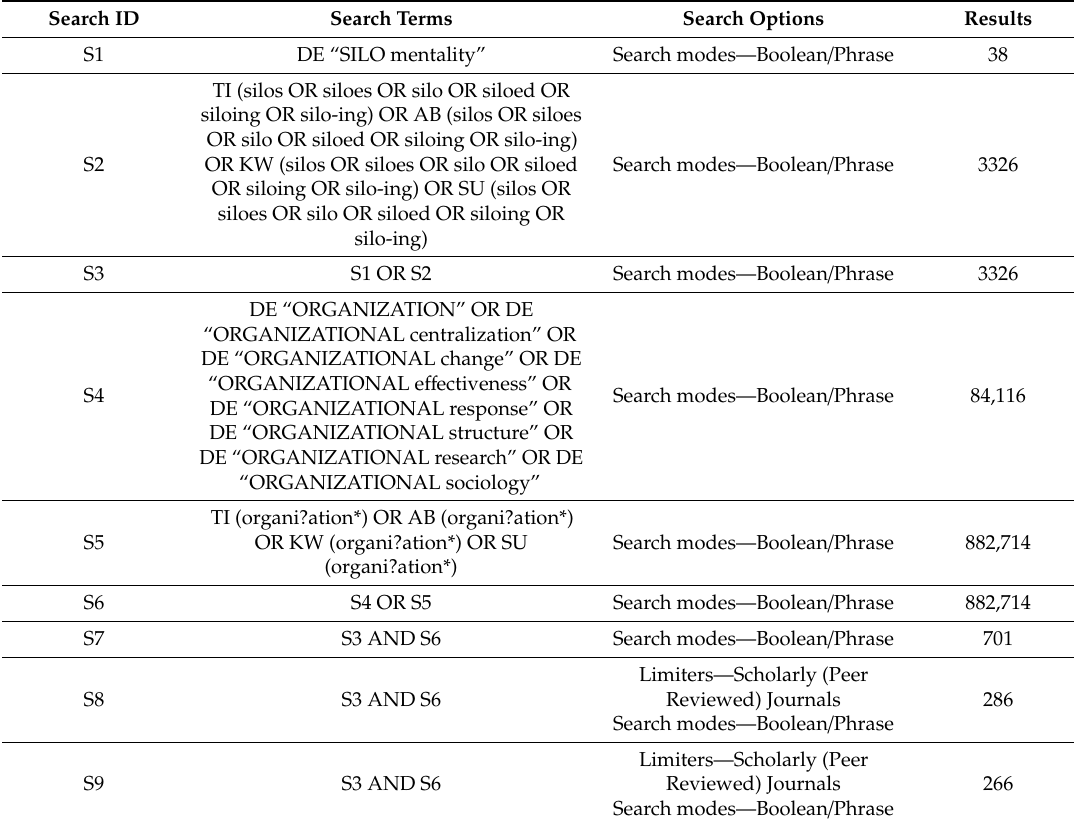
Complete search strategy on Business Source Elite (completed on 6 April 2020). Interface—EBSCOhost Research Databases Search Screen—Advanced Search Database—Business Source Elite.